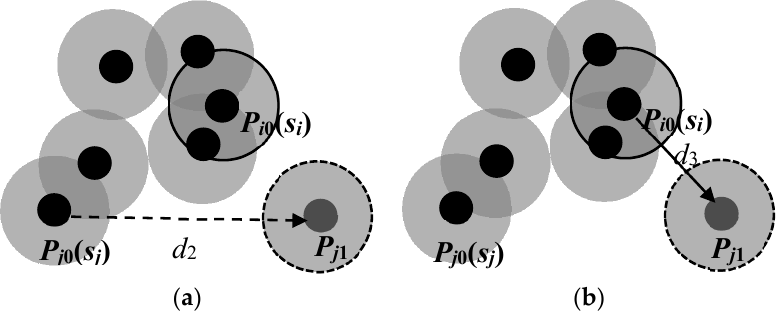
Figure 3. Movement replacement to reduce the average moving distance. ( a ) Sensor s j moves; ( b ) Sensor s i moves.